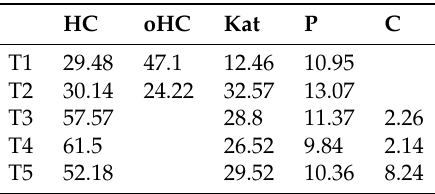
Table 1. Rietveld refinement of the temperature series of LDHs T1 = 20 ◦ C, T2 = 40 ◦ C, T3 = 60 ◦ C, T4 = 80 ◦ C and T5 = 90 ◦ C. HC indicated the phase [Ca 4 Al 2 (OH) 12 ][(CO 3 ) · 5H 2 O], oHC indicates the